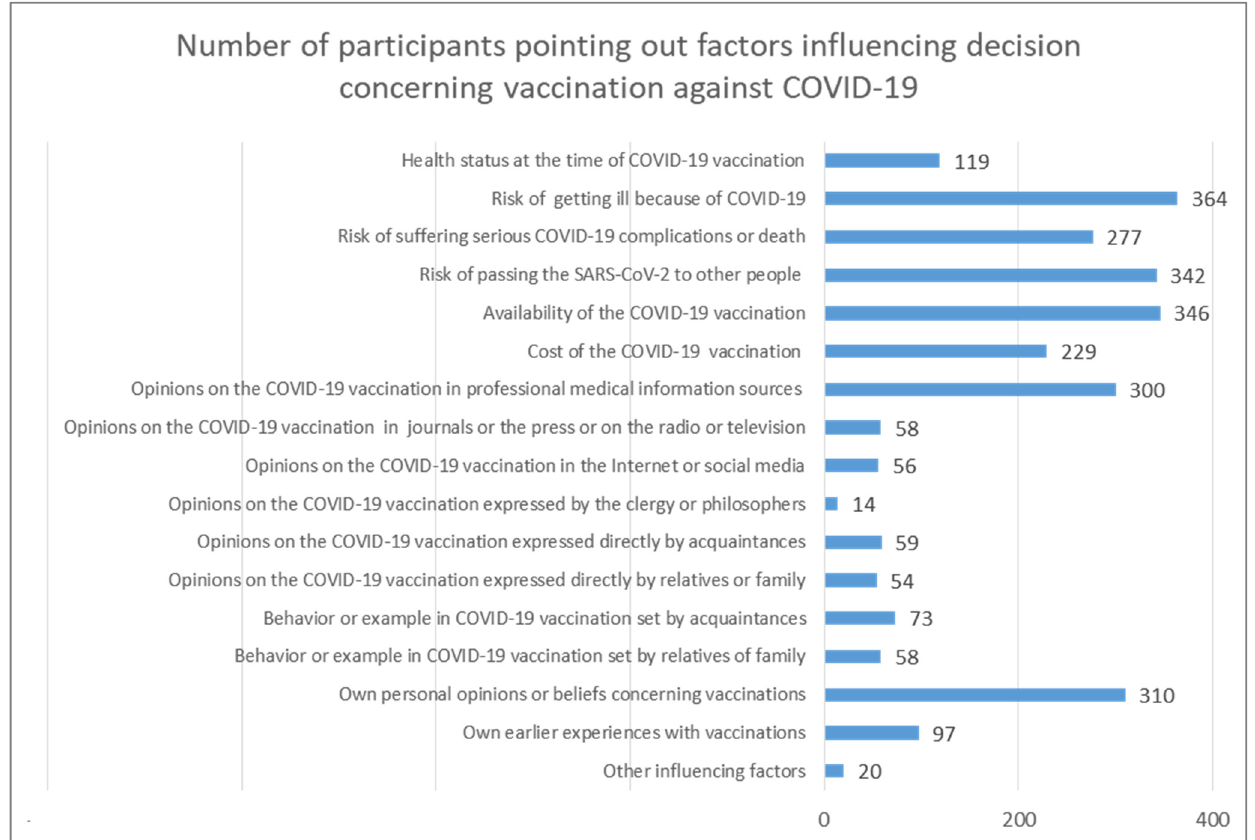
Figure 3. Number of participants pointing out factors influencing their decision concerning vaccina- tion against COVID-19.